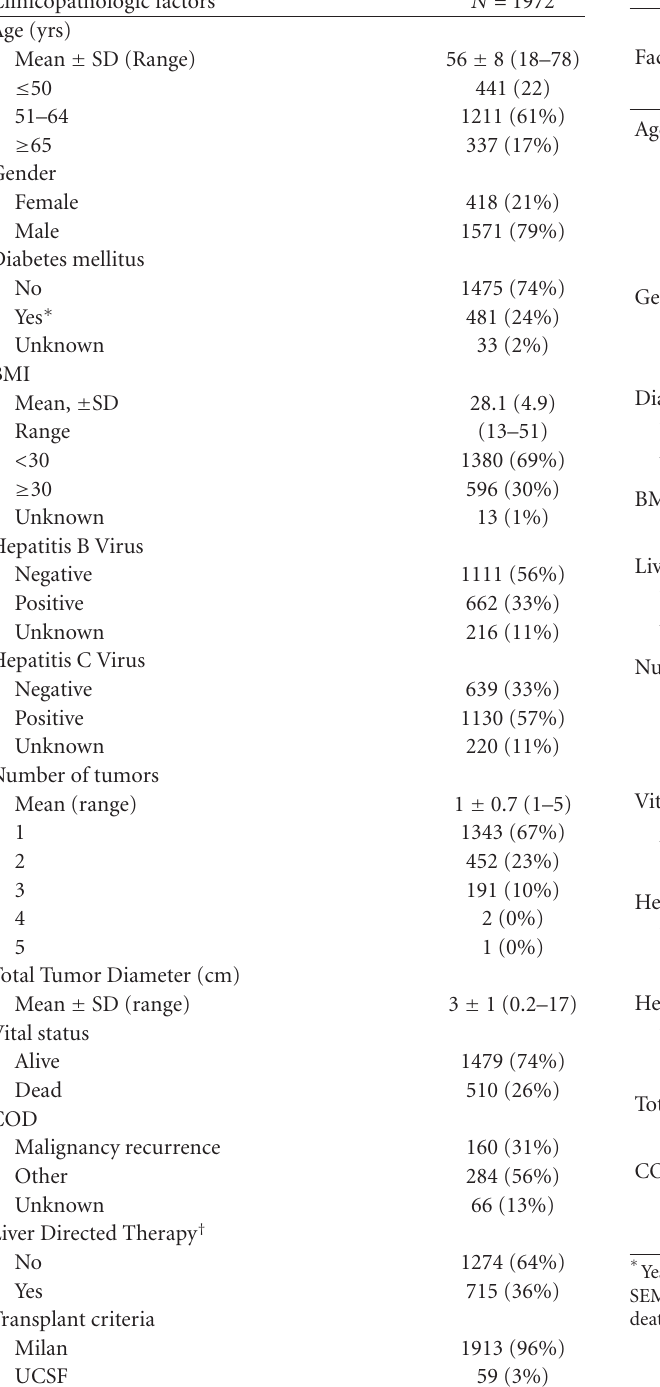
Table 2: Comparison of patient characteristics by transplant